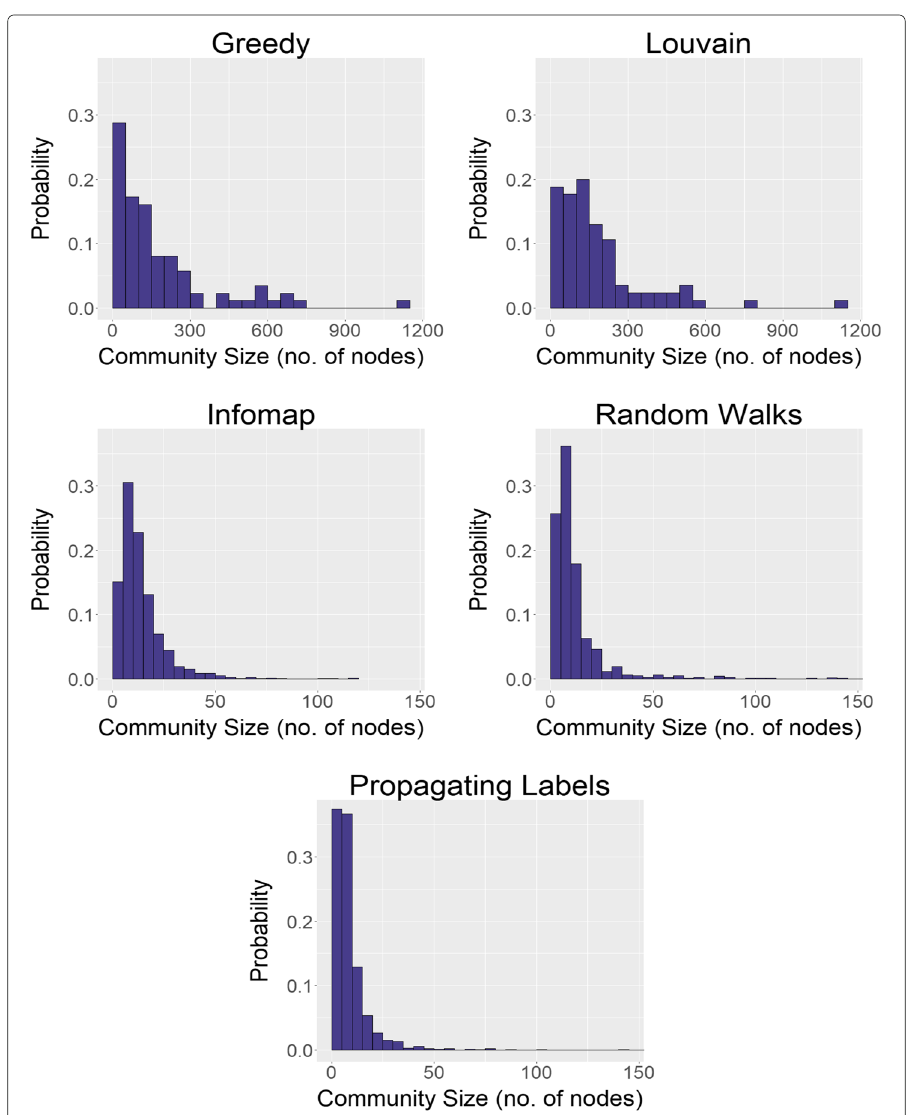
Fig. 2 Size distributions of inventor communities found by different algorithms. Shown here are distributions for the number of nodes within the communities identified on the largest connected component of the co-inventor network by the Greedy, Louvain, Infomap, Random-Walks, and Propagating-Labels algorithms. Note the different bin widths: 50 (5) nodes in the plots in the first (second, third) row. For Propagating Labels (Random Walks), one community with 262 nodes (twelve communities with 163, 169, 172, 175, 194, 222, 346, 387, 393, 583, 656, and 1060 nodes, respectively) is (are) outside the displayed range. See also Table 3